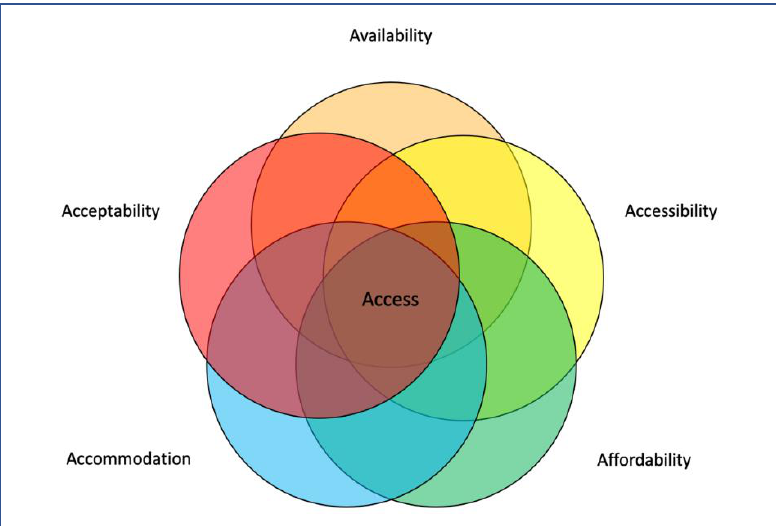
Figure 1 . Adapted from Penchansky and Thomas’ (1981) Dimensions of Access